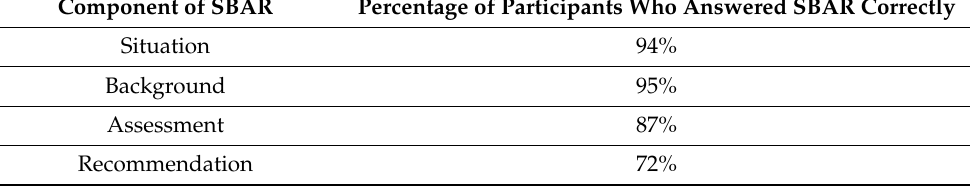
Table 3. Participants who answered SBAR